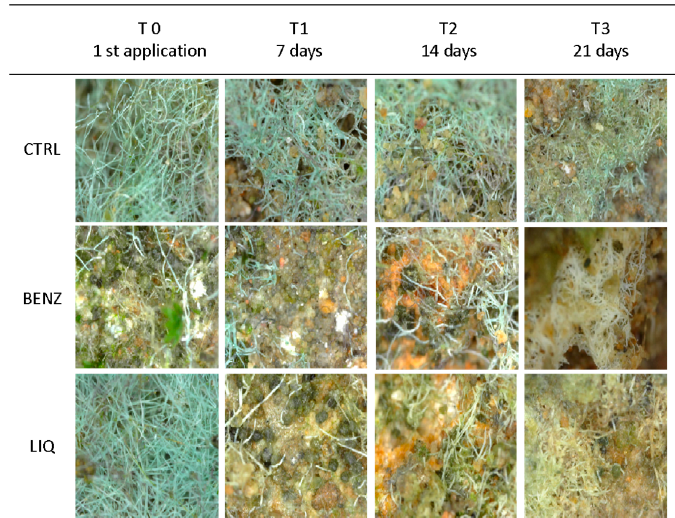
Figure 7. In situ Digital Microscope pictures of the treated surfaces at different time intervals acquired with Handheld Digital Microscope (USB) Dino-Lite Premier 1.3 MP (AnMo Electronics Corporation, Taiwan). The effect of LIQ and BENZ on the discolouration of the biofilms is evident. The photosynthetic yields (Figure 6), measured 5 min after the application of benzalkonium, were significantly lower than the control and the liquorice treated biofilms ( p < 0.05).